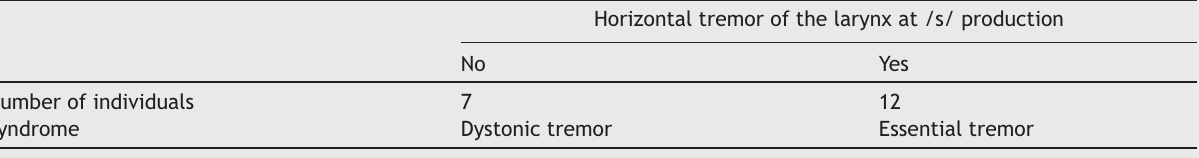
Description of the syndromic classification of patients according to the presence of horizontal tremor of the larynx at /s/ production.